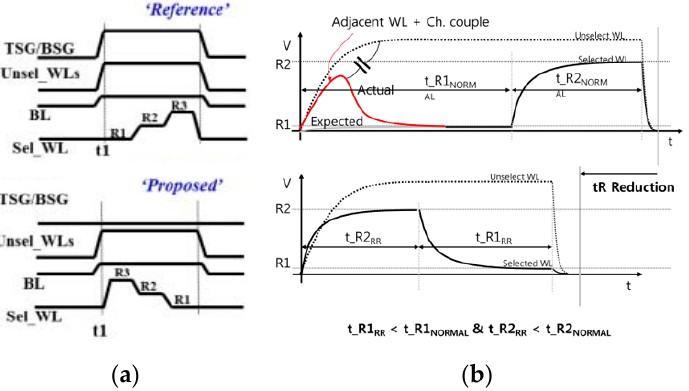
Figure 9. ( a ) The reference and proposed signal timing diagrams of the read operation. Reprinted/adapted with permission from Ref. [62], 2017, IEEE. ( b ) WL waveform of conventional and the proposed scheme. Reprinted/adapted with permission from Ref. [44], 2016, IEEE.